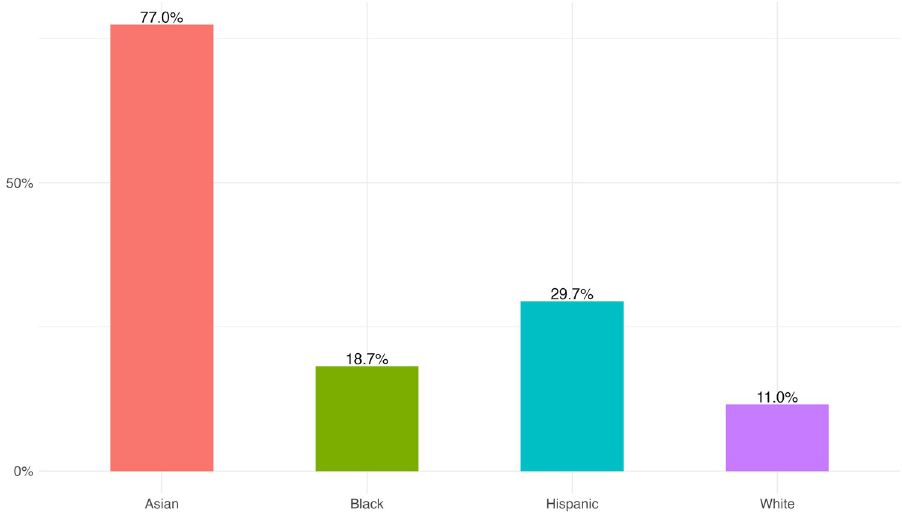
Fig 6. Proportion of Temporary Visa Holders by racial